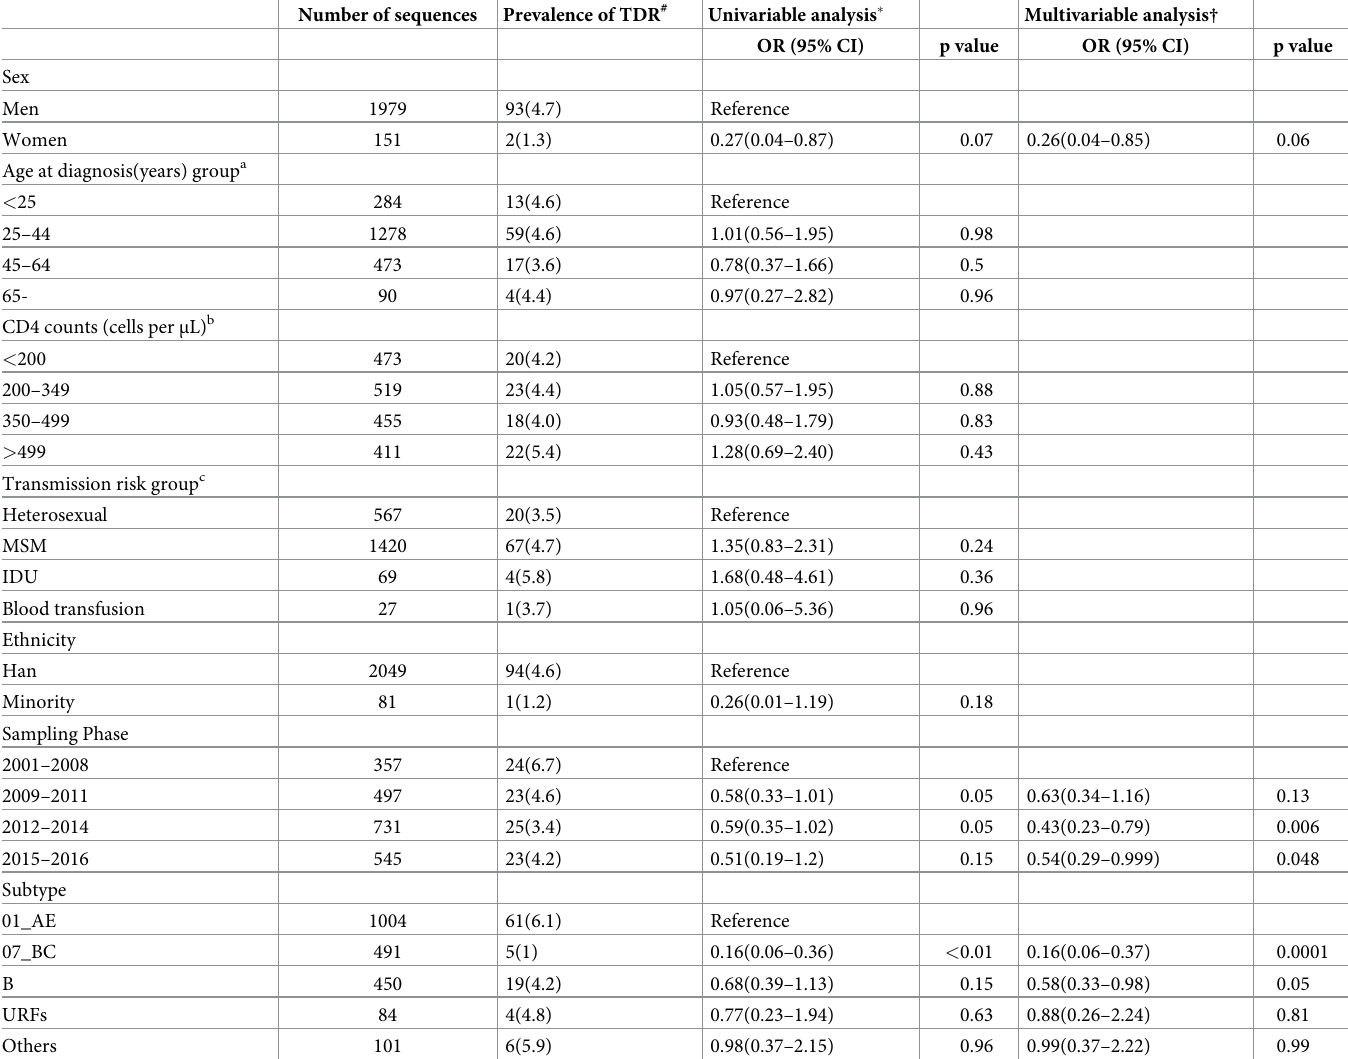
Table 3. Demographic and clinical factors associated with